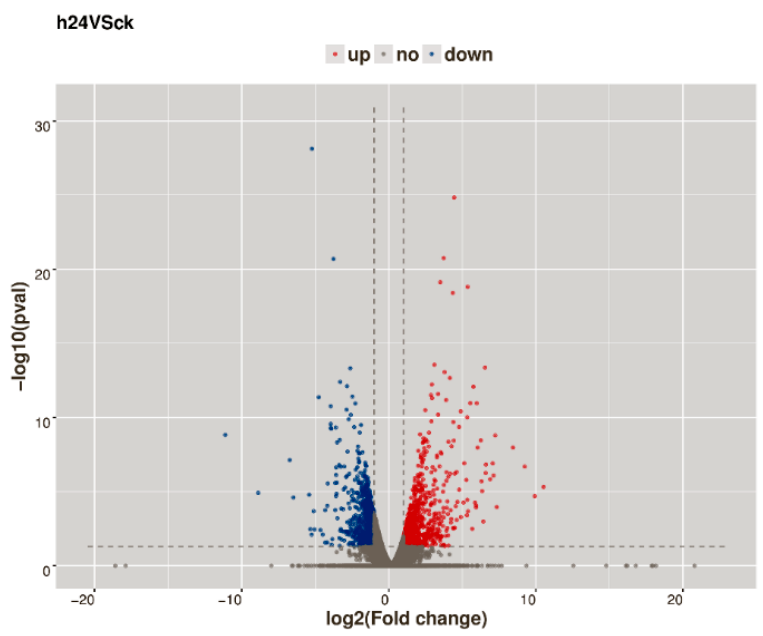
Figure 2. Volcano map representing the number of differentially expressed genes of watermelon leaf between the 24 hpi and ck. Red dots represent up-regulated genes, and green dots represent down-regulated genes.